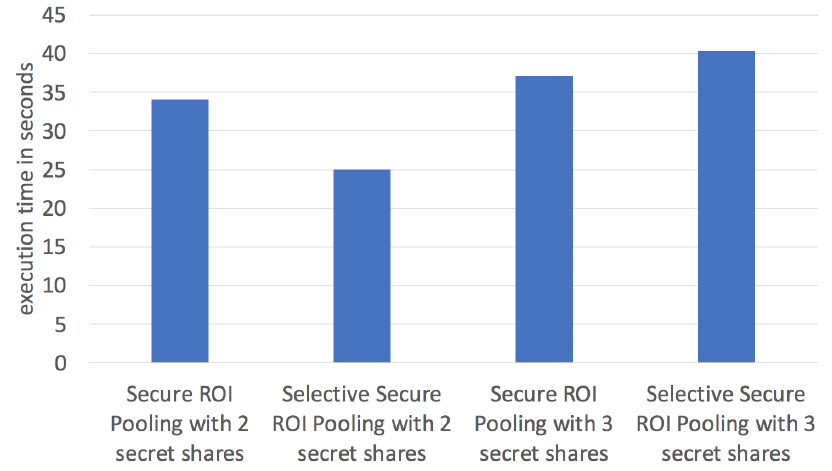
Figure 7. Performance comparison of secure ROI pooling and selective secure ROI pooling with two and three secure shares running vePOD Faster